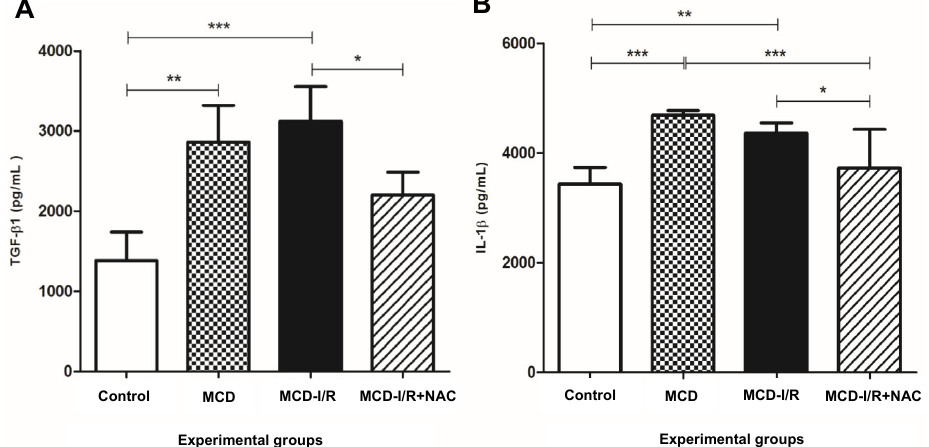
Figure 4. Concentrations of the pro-inflammatory cytokines in the liver of normal mice and of animals submitted to I/R in the MCD diet treated or not with N -acetylcysteine. The figure shows ( A ) cytokine IL-1β and ( B ) cytokine TGF-β1 (* p < 0.05, ** p < 0.01, and *** p < 0.001; N = 5–6; Bonferroni one-way